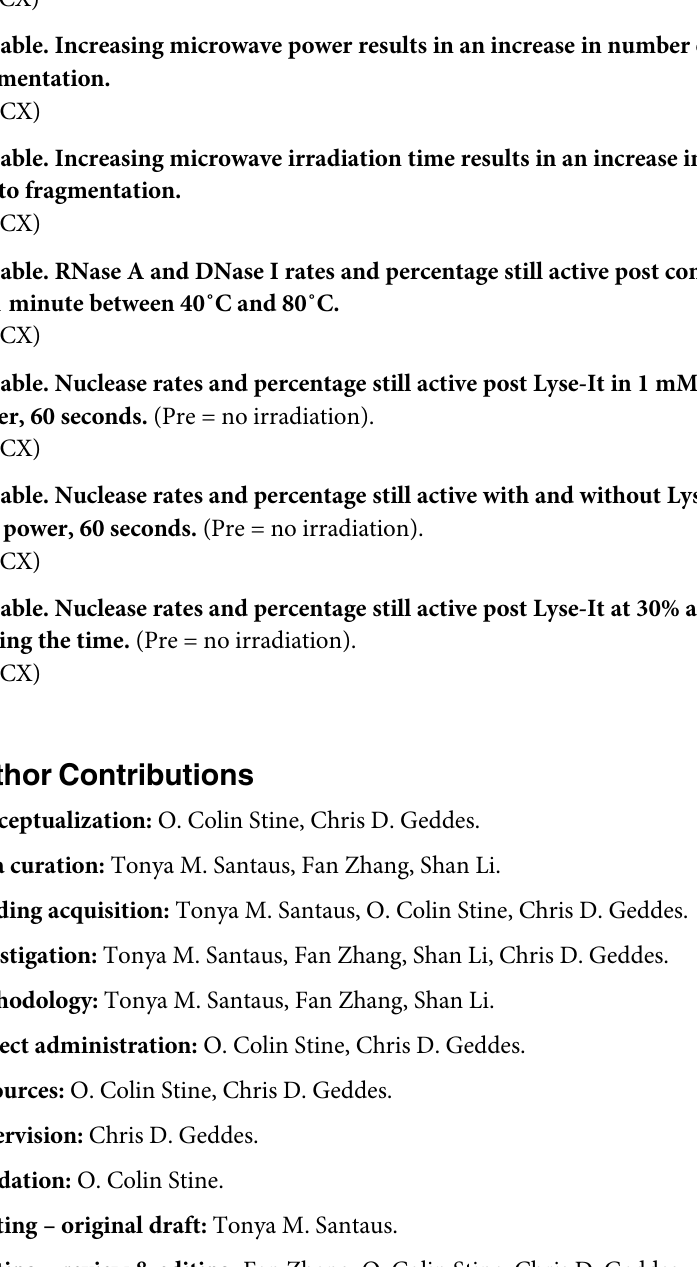
S1 Table. Fragment sizes determined post Lyse-It after purging with argon, air, or oxygen. Increasing oxygen concentration results in an increase in number of peaks due to fragmentation. S2 Table. Increasing microwave power results in an increase in number of peaks due to fragmentation. S3 Table. Increasing microwave irradiation time results in an increase in number of peaks due to fragmentation. S4 Table. RNase A and DNase I rates and percentage still active post conventional heating for 1 minute between 40˚C and 80˚C. S5 Table. Nuclease rates and percentage still active post Lyse-It in 1 mM buffers at 50% power, 60 seconds. (Pre = no irradiation). S6 Table. Nuclease rates and percentage still active with and without Lyse-It in DI water at 50% power, 60 seconds. (Pre = no irradiation). S7 Table. Nuclease rates and percentage still active post Lyse-It at 30% and 50% power, varying the time. (Pre = no